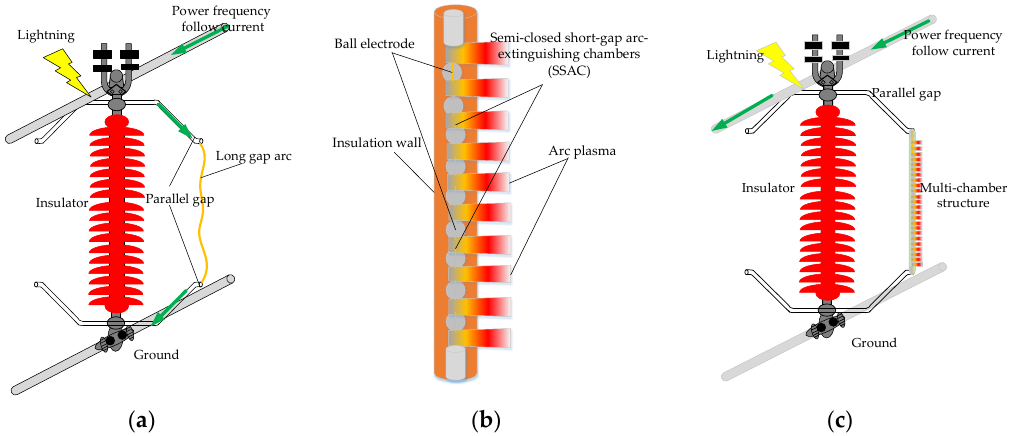
Figure 1. Multi-chamber arc-extinguishing structure and its installation: ( a ) Power frequency follow current after breakdown; ( b ) multi-chamber arc-extinguishing structure; ( c ) installation of the multi-chamber arc-extinguishing structure.